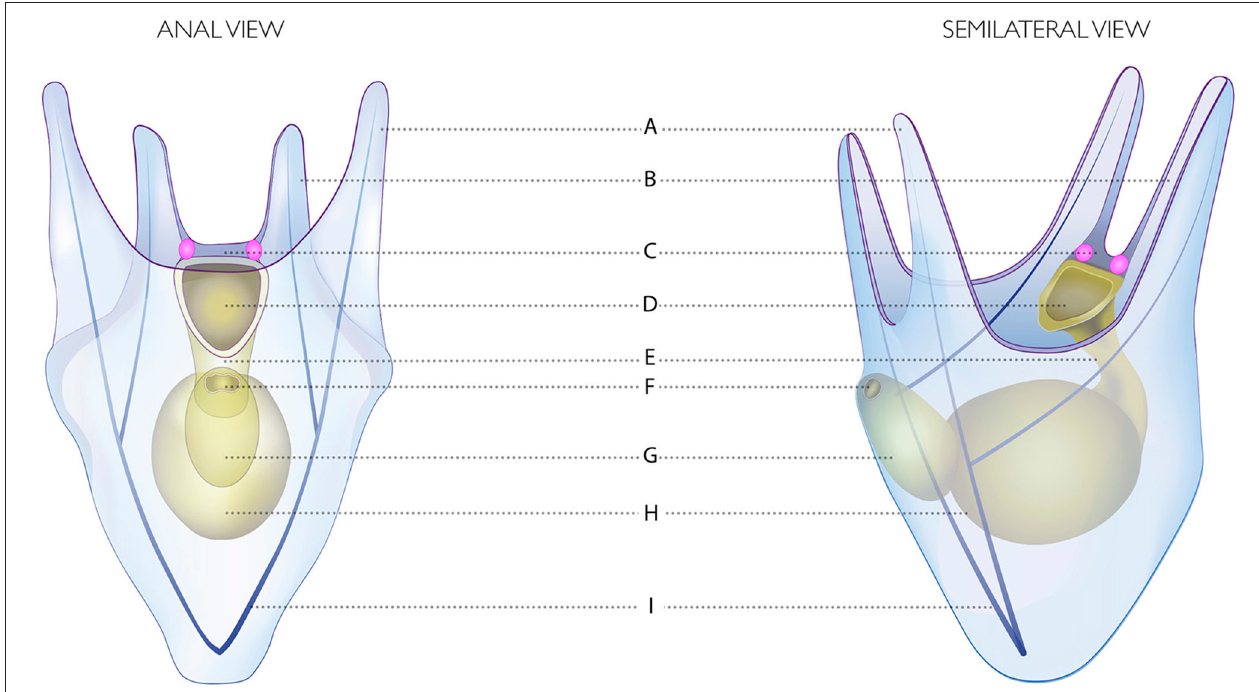
FIGURE 2 | Drawing of the four-armed pluteus of S. purpuratus . (A) Postoral arms. (B) Anterolateral arms. (C) Apical organ. (D) Mouth. (E) Esophagus. (F) Anus. (G) Intestine. (H) Stomach. (I) Skeletal rods. The Go Sp-opsin3.2 opsin positive cells are represented in